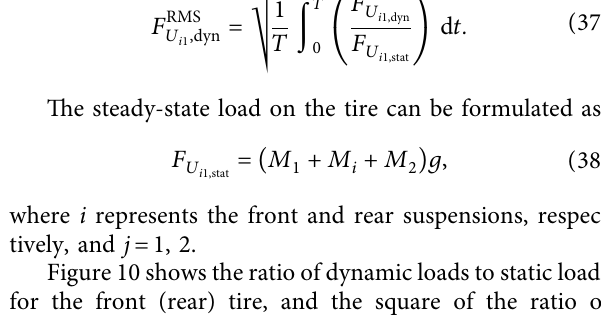
Figure 6: Responses of velocities _ U of half vehicle system coupling with the HNES model while excitation is bump road inputs and the n velocity of vehicle is 1.1256m/s (a) and 20m/s (b). The vector _ U presents the velocities of the driver, the chassis, and the pitch n the RMS (root mean square) value of the forces, which are